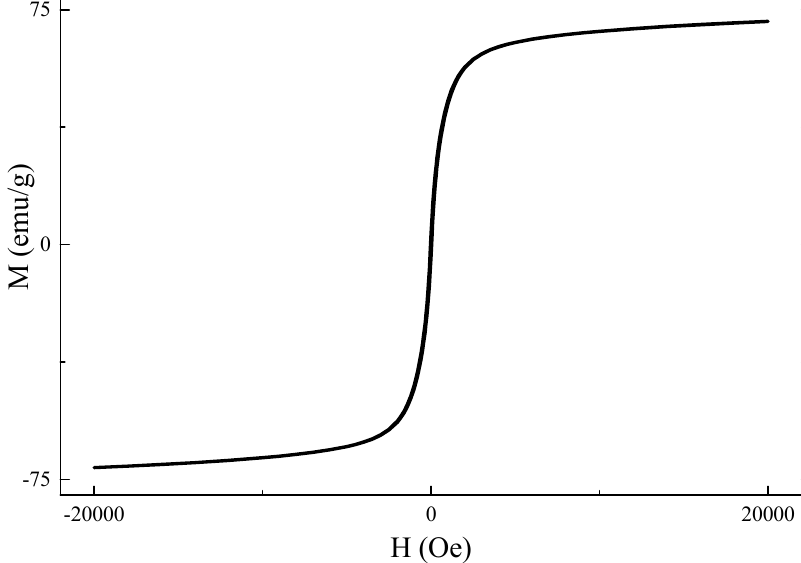
Figure 2. Wide-angle X-ray diffraction pattern of synthesized Fe 3 O 4 nanoparticles.